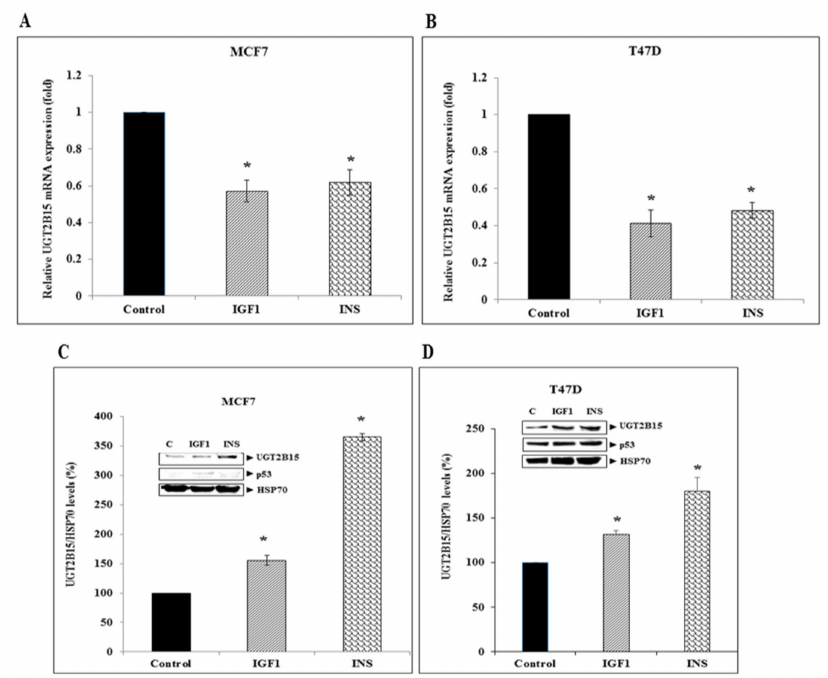
Figure 5. Regulation of UGT2B15 gene expression by IGF1 and insulin in breast cancer cell lines. MCF7 ( A ) and T47D ( B ) cells were treated with IGF1 or insulin (50 ng/mL) for 24 h, after which total RNA was prepared and UGT2B15 mRNA levels were measured by RT-QPCR. A value of 1 was given to the UGT2B15 mRNA levels in control, untreated cells. * p < 0.01 vs. respective control cells. ( C , D ) MCF7 and T47D cells were treated with IGF1 or insulin for 24 h, after which total protein was prepared and UGT2B15 and p53 levels were measured by Western blots. Bar graphs represent UGT2B15 levels normalized to the corresponding HSP70 values. A value of 100% was given to control, untreated cells.